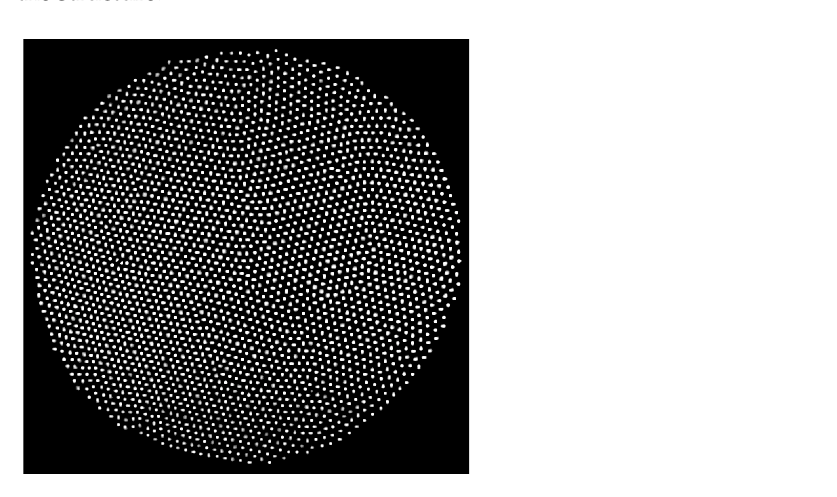
Figure 1. Video frame of isotropic dust monolayer structure in plasma of RF discharge at W = 6.9 W, P = 5 Pa.